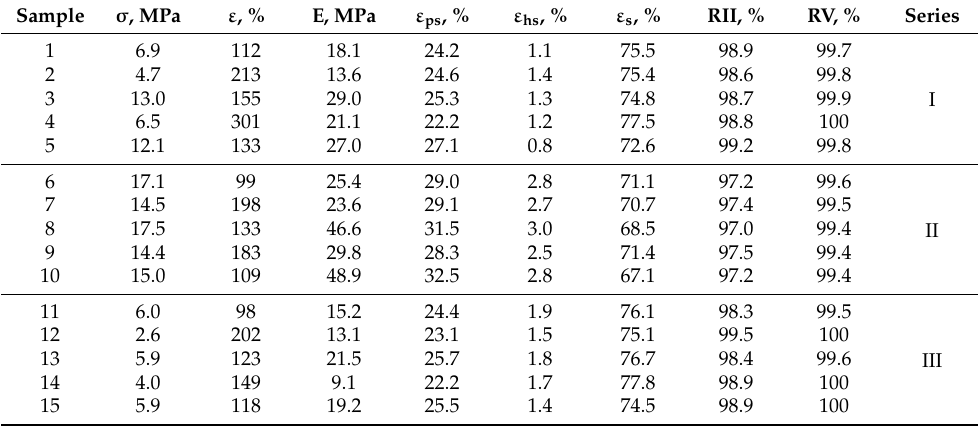
Table 7. Mechanical and elastic properties of